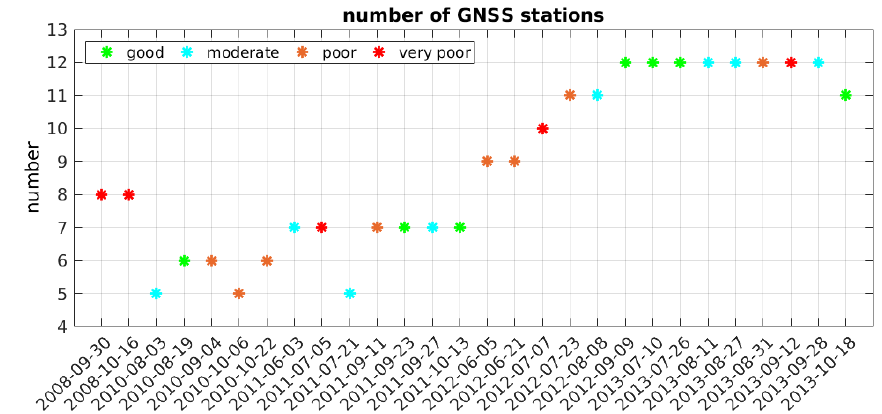
Figure 15. Number of stations for each acquisition. The colors denote levels of agreement between GNSS and